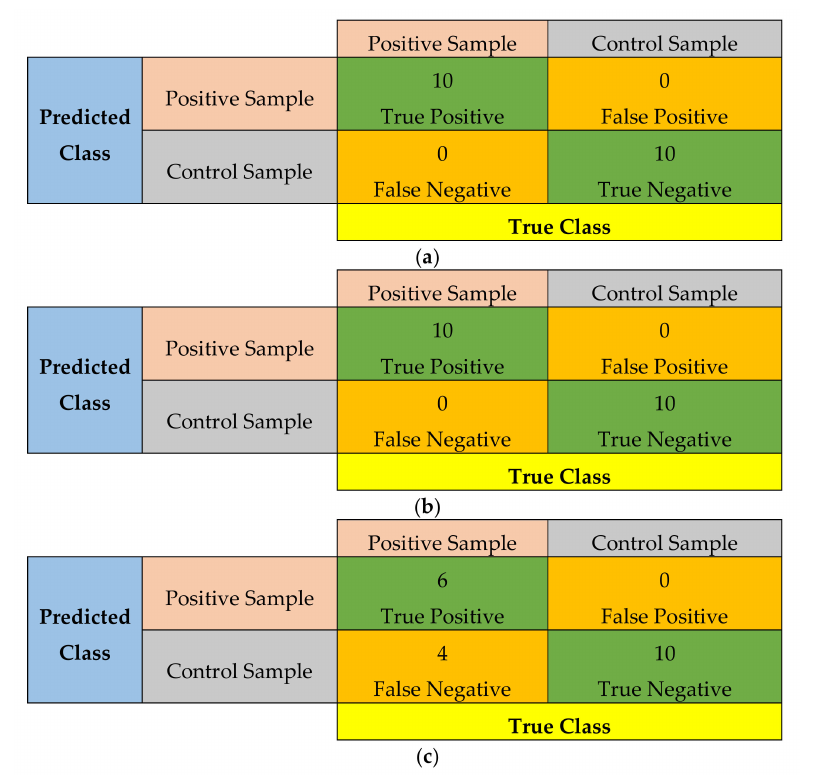
Figure 9. Confusion matrix from samples of: ( a ) high concentration, 231 µ M; ( b ) medium concentration, 1.5 µ M, and; ( c ) low concentration, 231